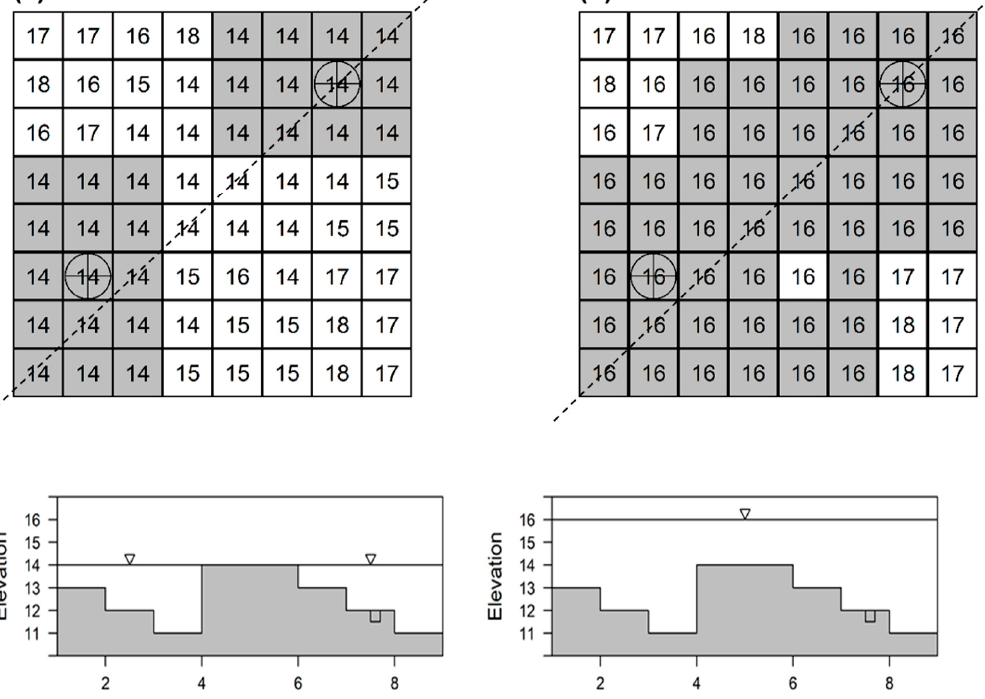
Figure 2. Schematic diagram showing flood inundation from two manholes (the circles with cross) for different amounts of manhole overflow: ( a ) 22 units from the left manhole and 19 units from the right manhole, ( b ) 110 units from the left manhole and 111 units from the right manhole. The numbers inside the unshaded and unshaded grids represent surface elevation and flood levels, respectively. Dash line represents the profile line.